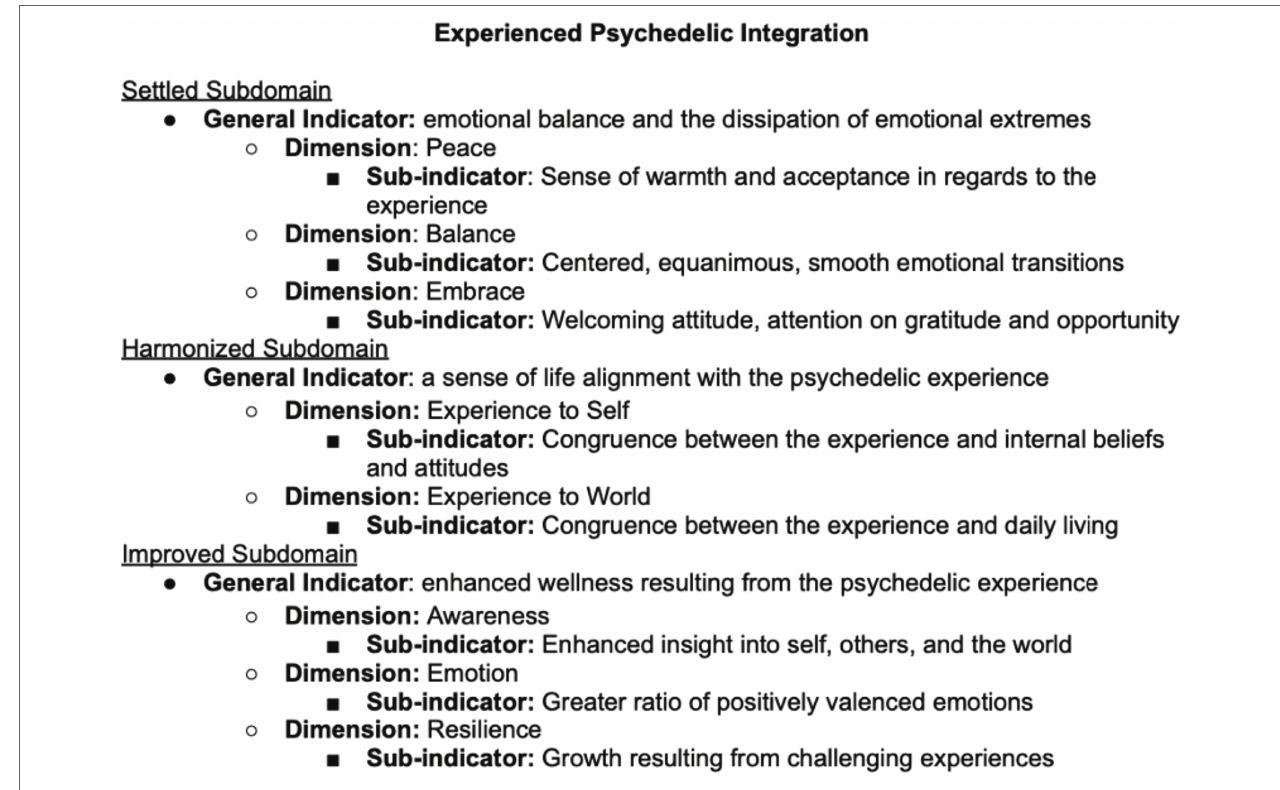
FIGURE 4 | Subdomains, indicators, and sub-indicators for the experience of integration scale